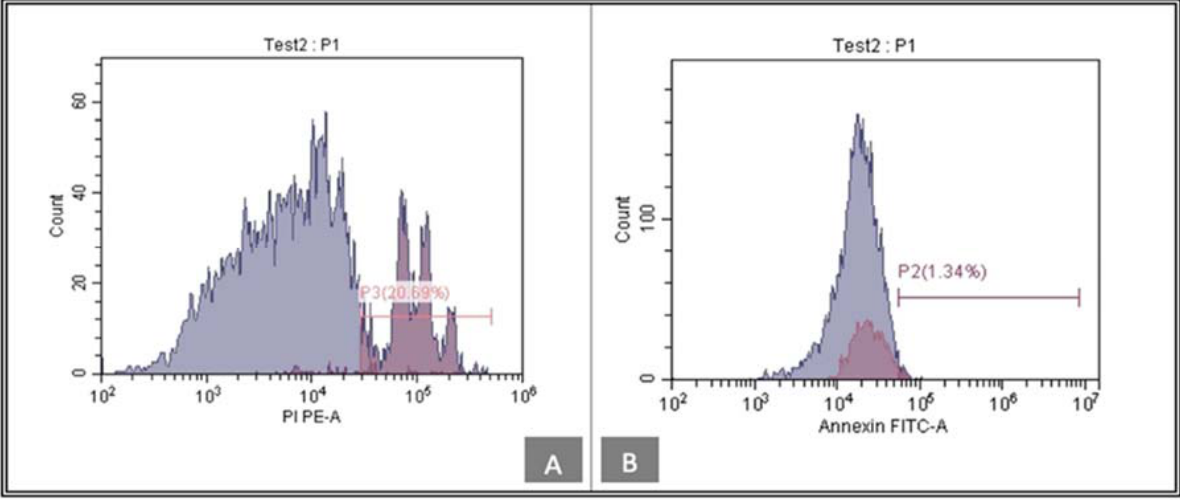
Figure 7. ( A ) Annexin ‐ V analysis by flow cytometry was used to analyze apoptosis in CHIR99021 group. ( B )The percentage of apoptotic cells was 1.34%. FITC, fluorescein isothiocyanate.